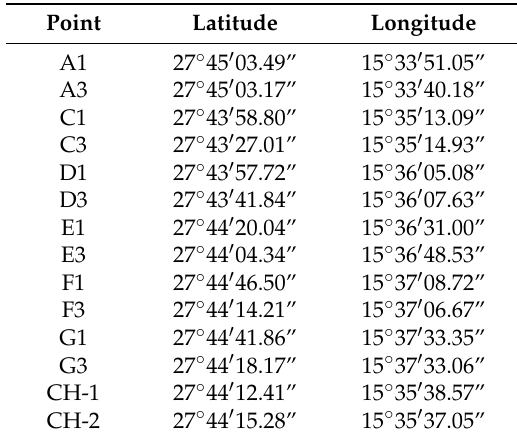
Table 3. Location of corresponding in-situ sampling sites of Figure